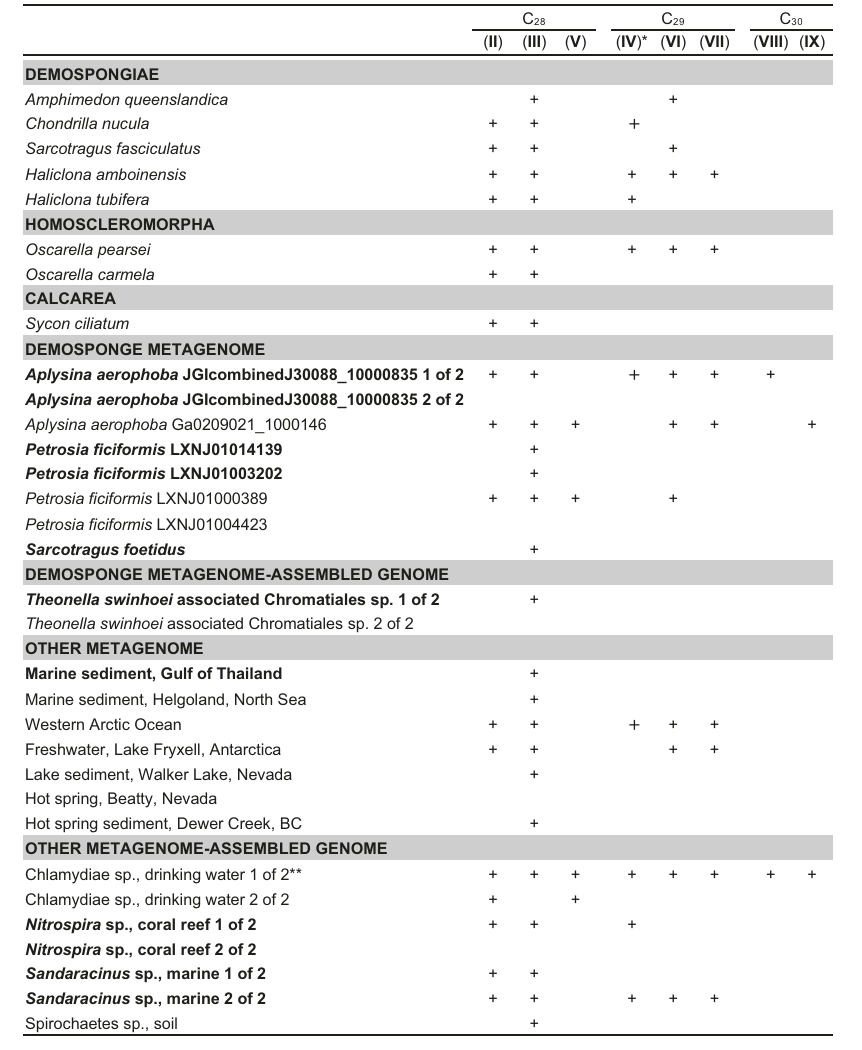
Fig. 2 | Sterols identi fi ed as products of sponge and bacterial sterol methyl- transferase in vitro reactions. Sterols were detected using GC-MS. Products of in vitro reactions performed with both desmosterol and 24-methylenecholesterol as substrates are included. C 28 sterols include (epi)codisterol ( II ), 24- methylenecholesterol( III ),and24-methyldesmosterol( V ).C 29 sterolsinclude(epi) clerosterol( IV ),fucosterol( VI ),andisofucosterol( VII ).C 30 sterolsinclude24 S − 24- isopropylcholesta-5,25-dienol ( VIII ) and 24-isopropylcholesta-5,24-dienol ( IX ).